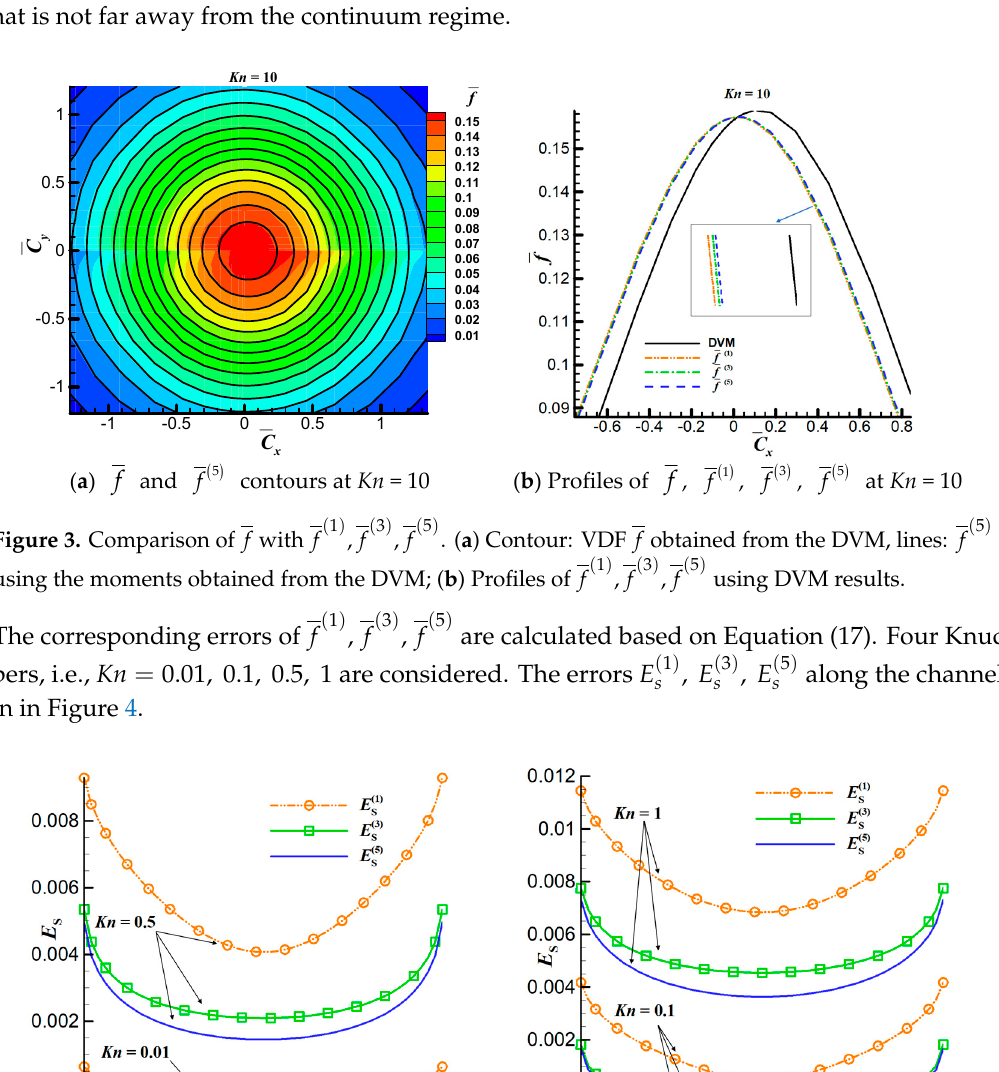
( 1 ) ( 3 ) ( 5 ) Figure 4. E Figure 4. along the channel at ( a ) 0 01 and 0 5 Kn . . = 0 1 and 1 Kn . = . s , E s , E s along the channel at ( a ) Kn